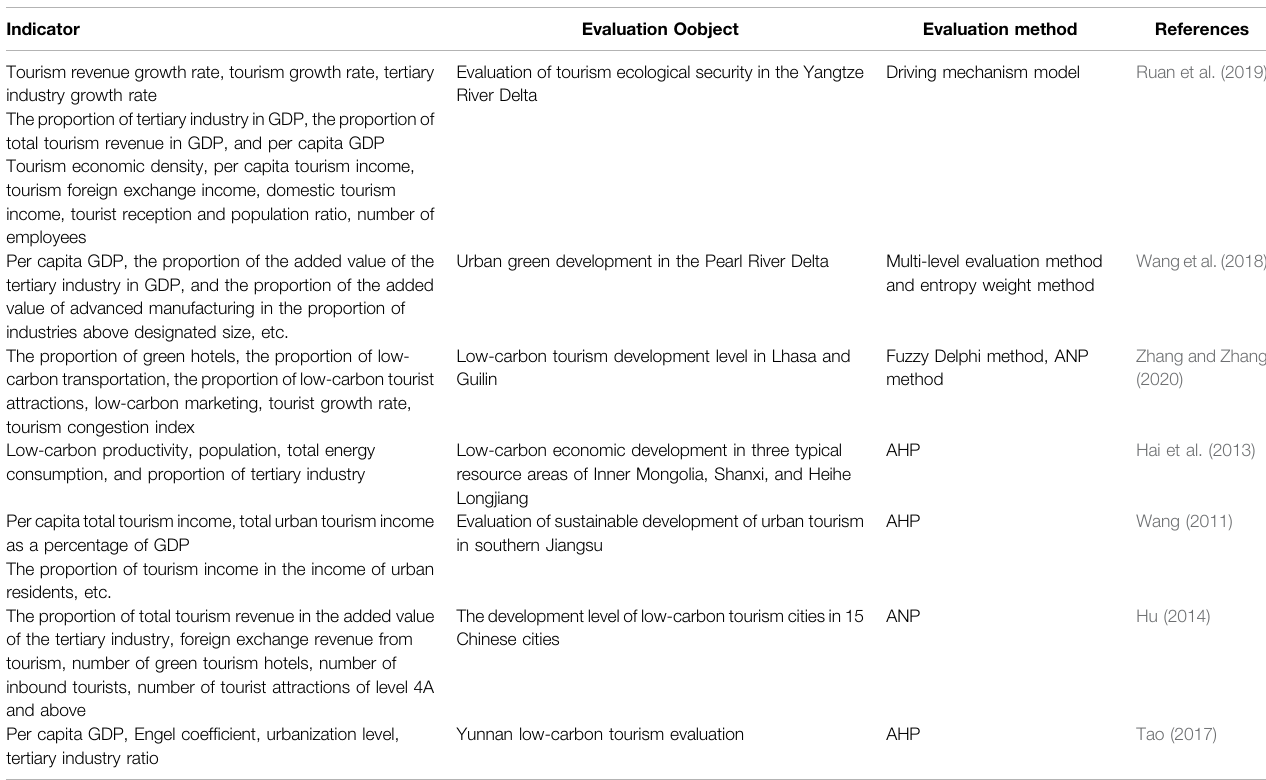
TABLE 1 | Indicators of the economic